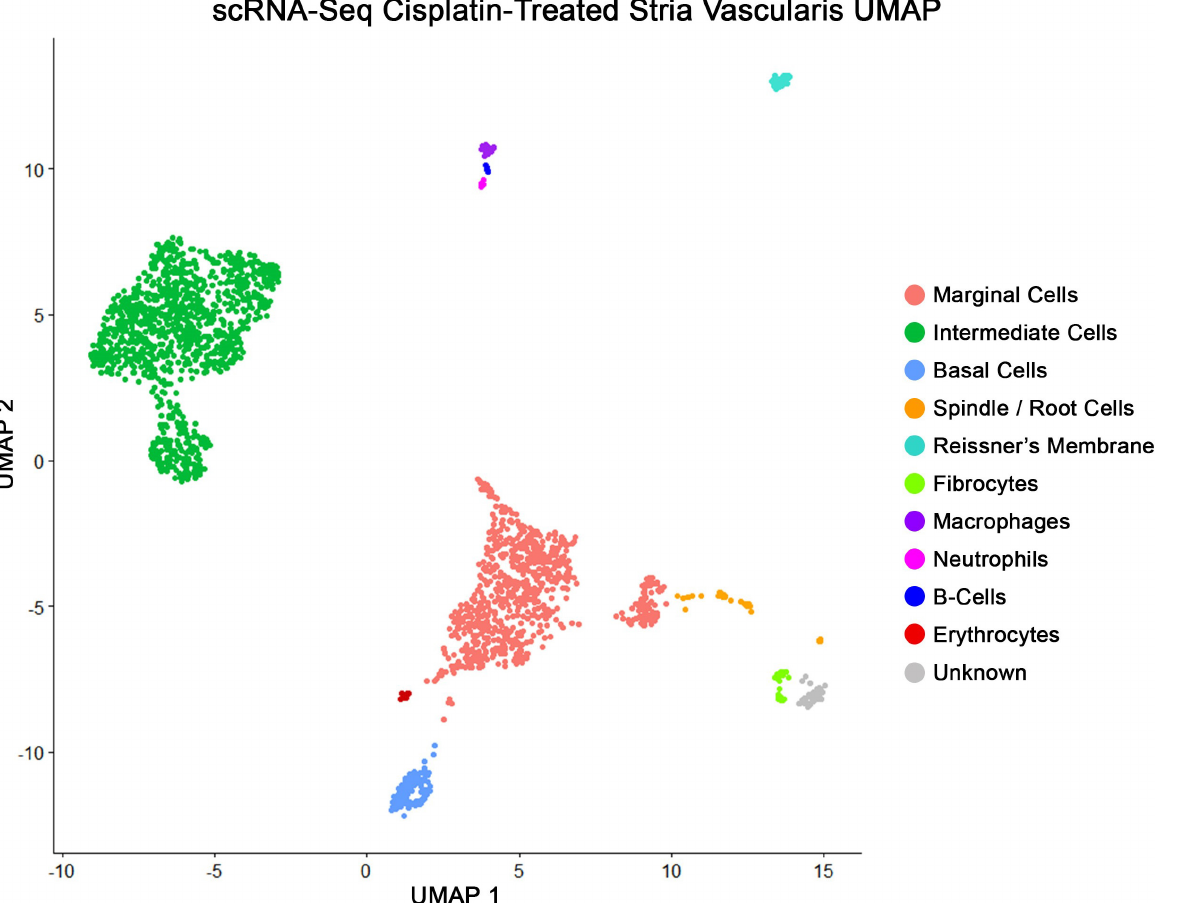
approved drugs that either promote or inhibit